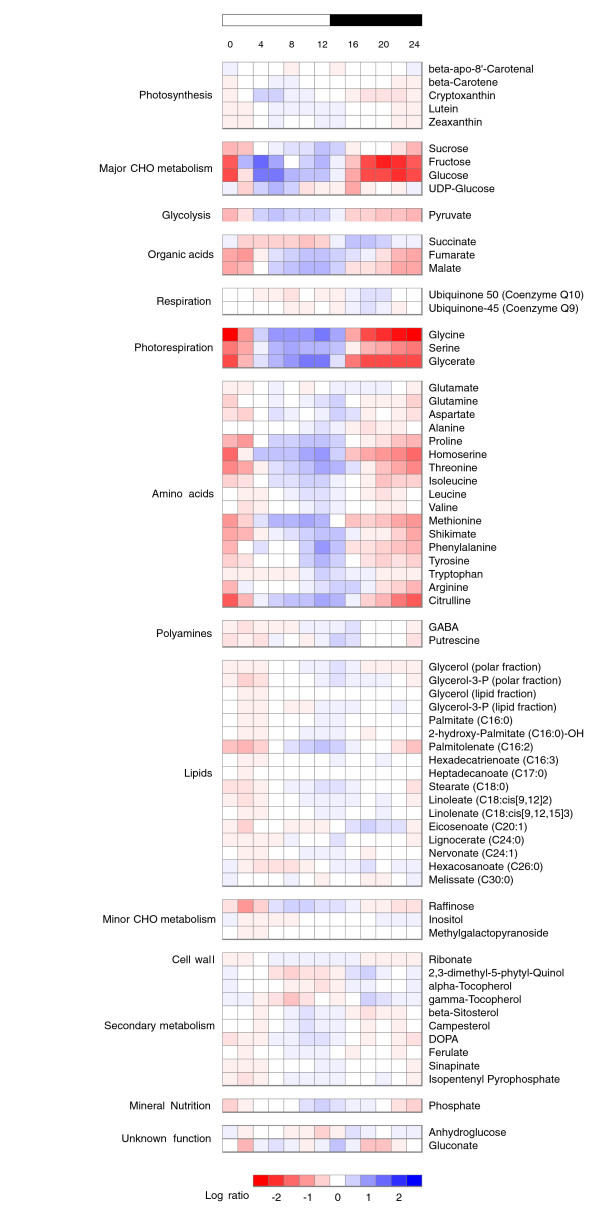
Heat map representing the changes in metabolite levels in rosettes of Arabidopsis. Metabolites of Col0 WT plants growing in 12 h light and 12 h night throughout one day and night cycle are shown. Log2 ratios were calculated for each value by dividing it by the average. Log2 ratios give the intensity of the blue or red colors according to the scale bar. CHO, carbohydrate.